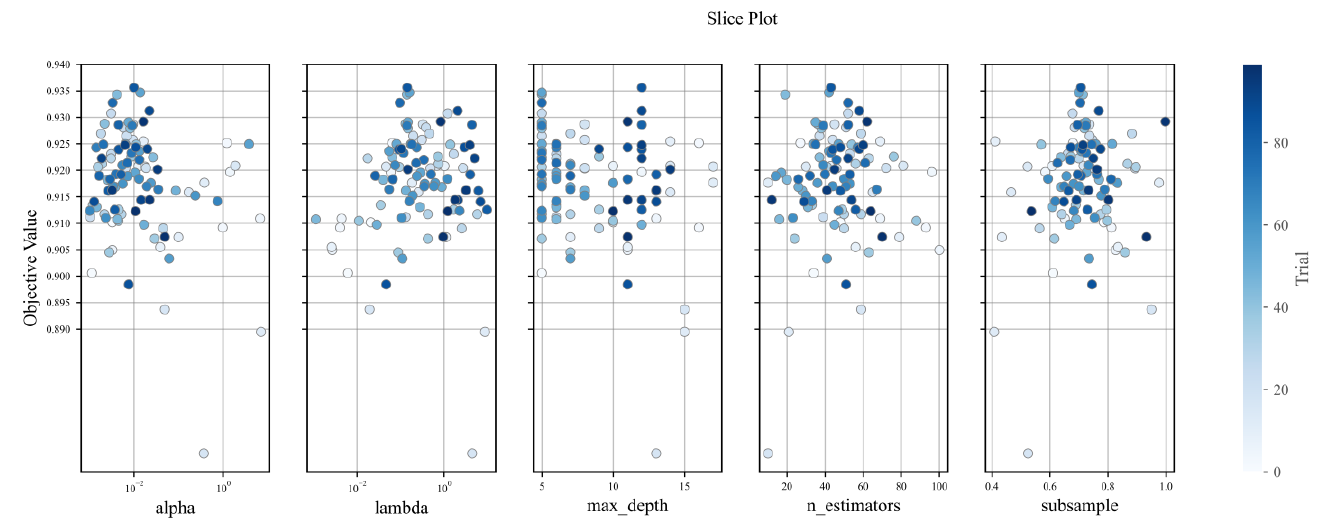
Figure 5. Bayesian hyperparameter optimization process for 100 iterations.